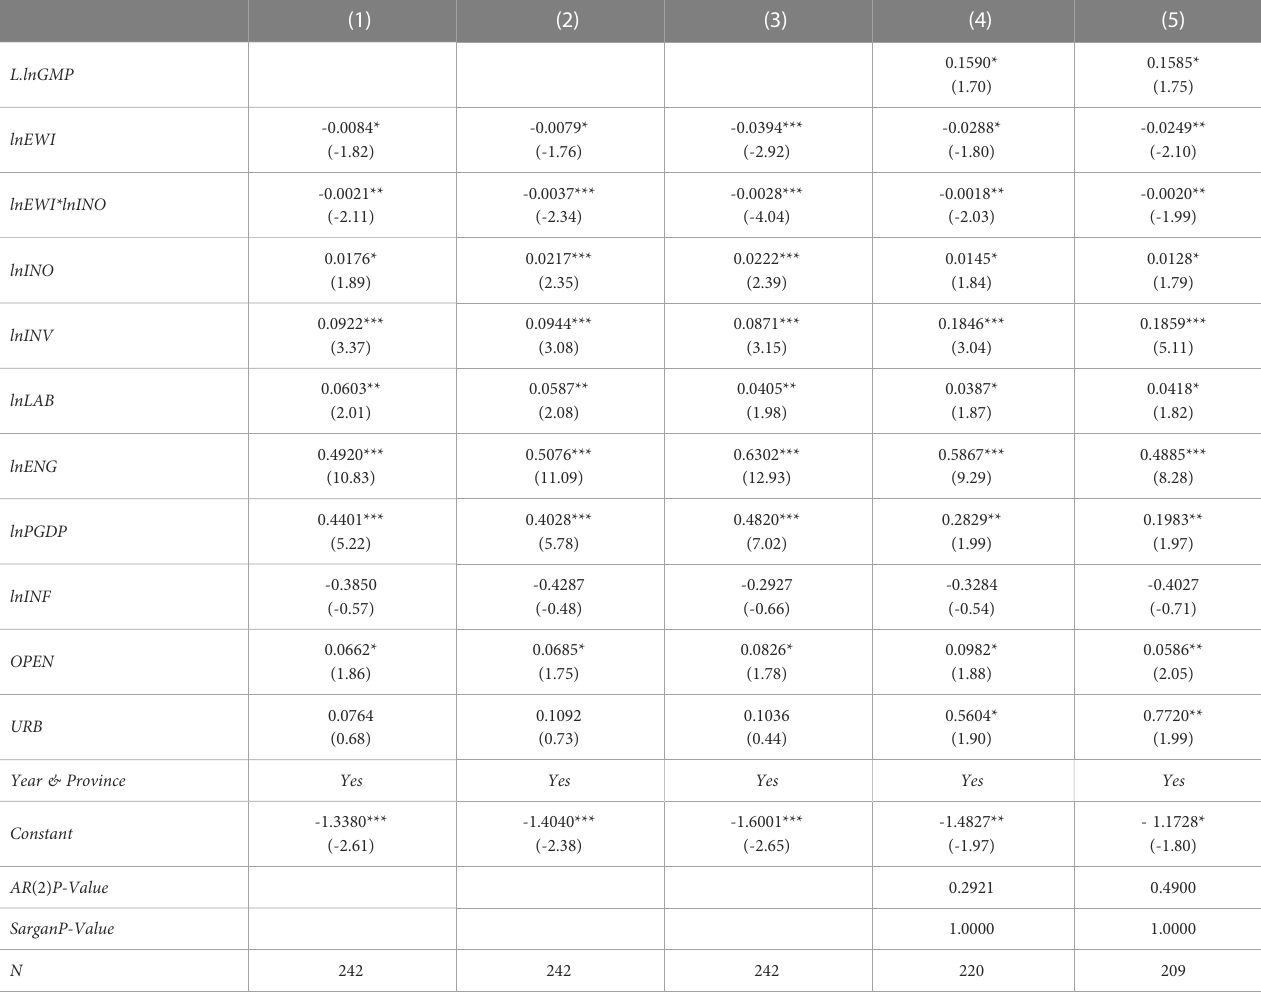
TABLE 2 Moderating effect